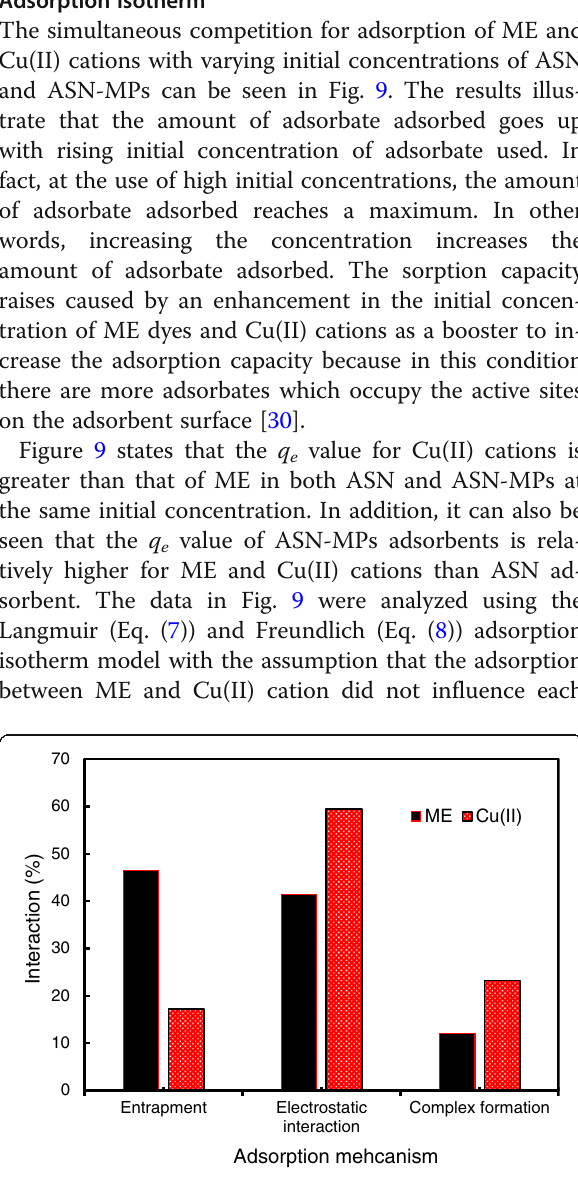
Fig. 8 Contribution of the adsorption mechanism of ME and Cu(II) cations to ASN-MPs material